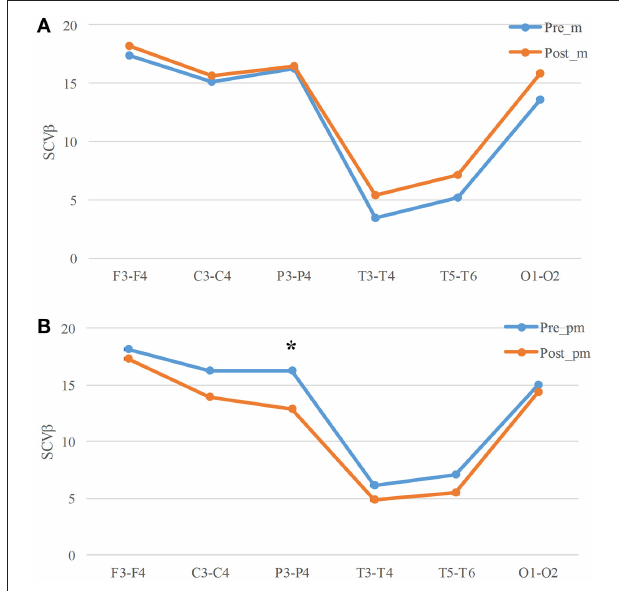
FIGURE 5 | SCV β for mental (A) and physical mental tasks (B) . * p <